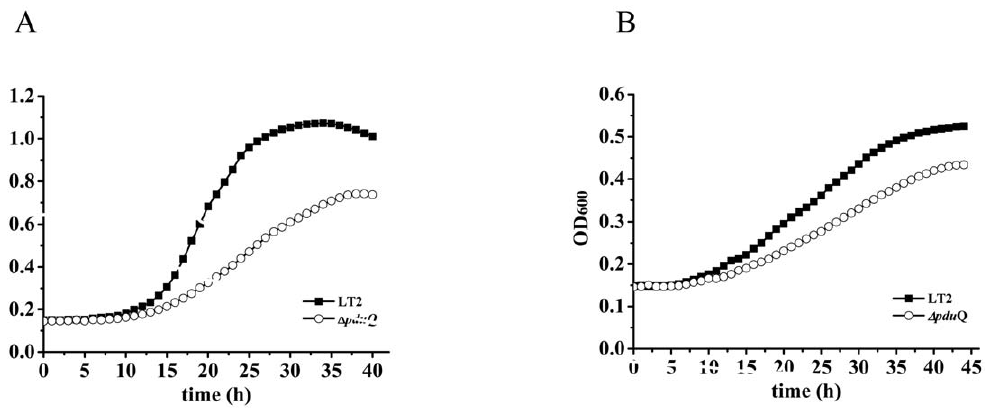
Figure 3. A pduQ deletion mutant grows slowly on 1,2-PD. Cells were grown on minimal 1,2-PD medium with saturating (150 nM) or limiting (20 nM) CN-Cbl (vitamin B 12 ): panels A or B, respectively. Symbols meanings are indicated on the figure.